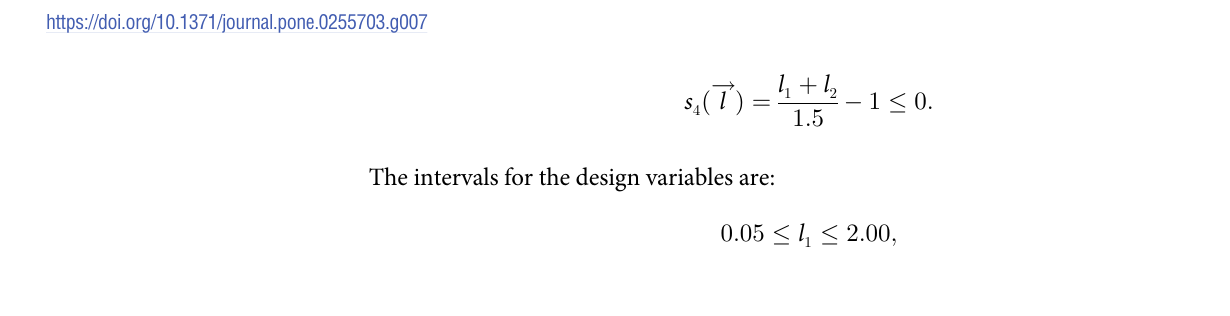
PLOS ONE | https://doi.org/10.1371/journal.pone.0255703 August 24,